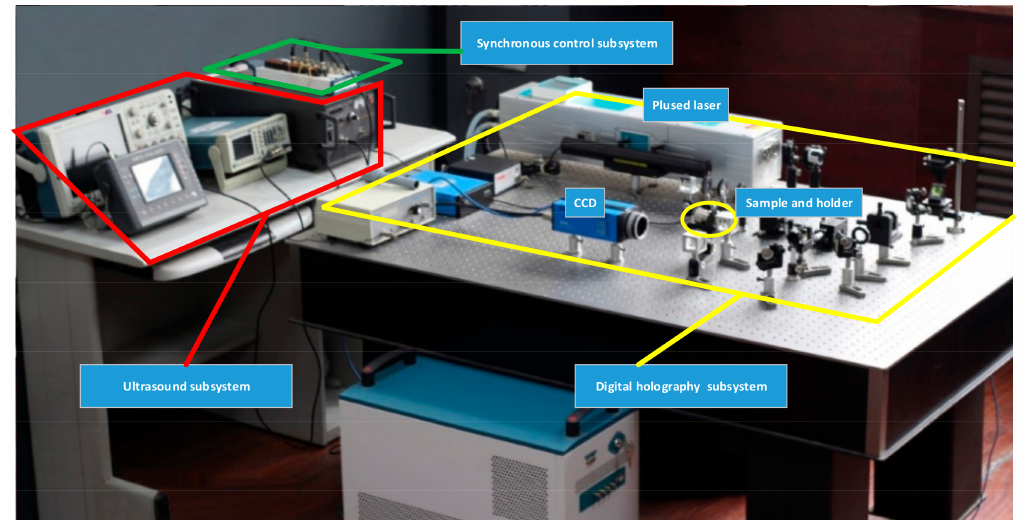
Figure 13. The proposed 3D Ultrasonic Wavefields measurement system.